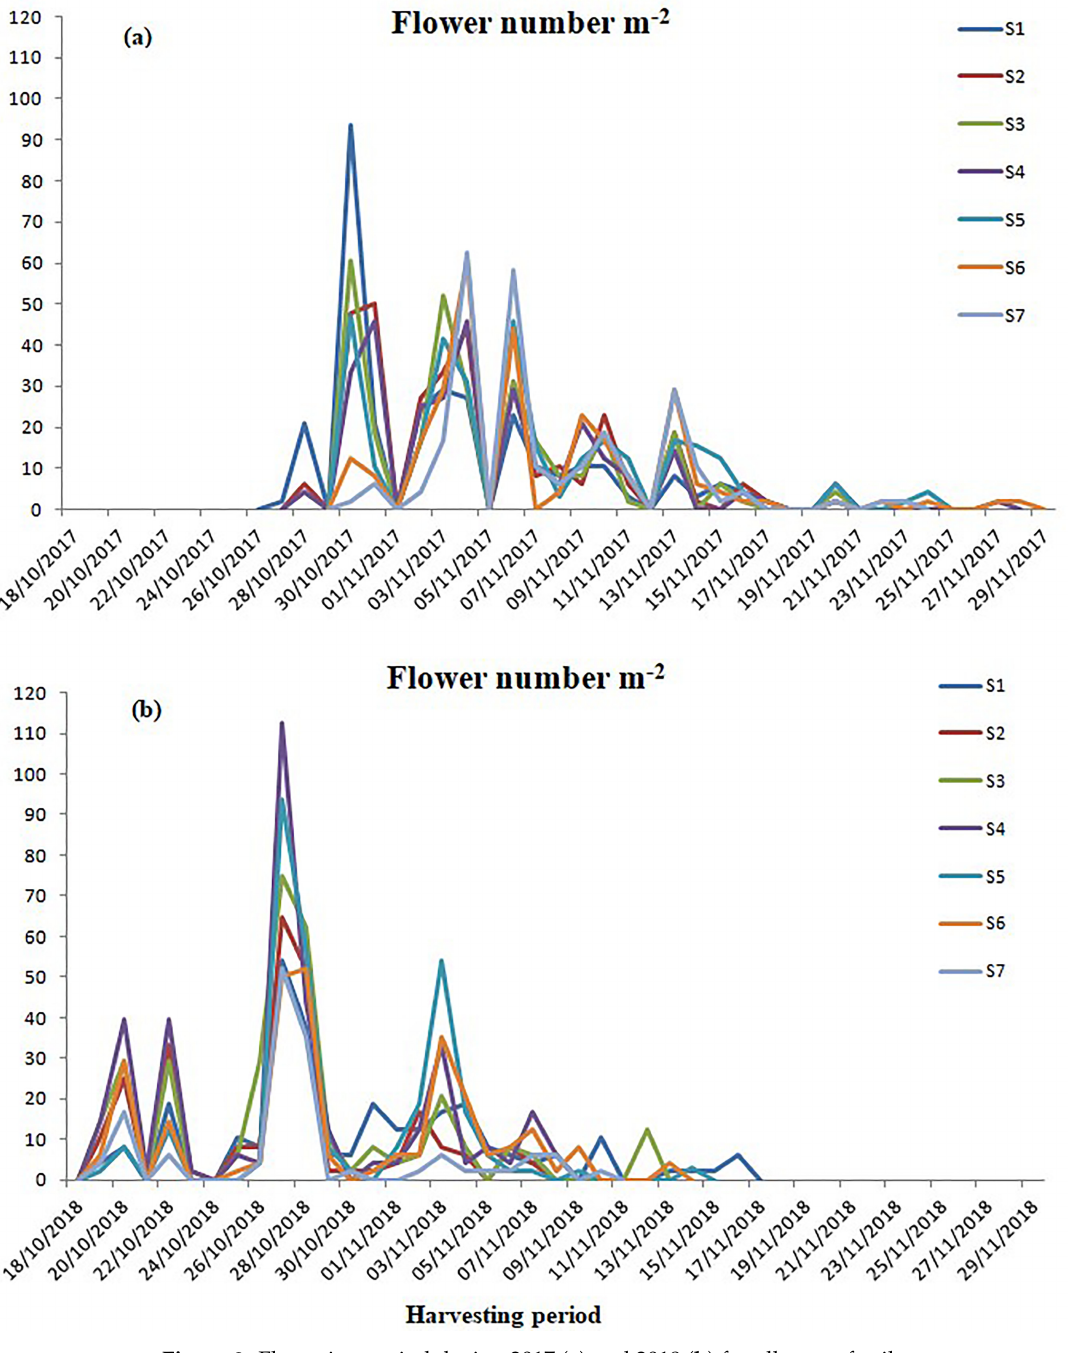
Figure 2. Flowering period during 2017 ( a ) and 2018 ( b ) for all type of